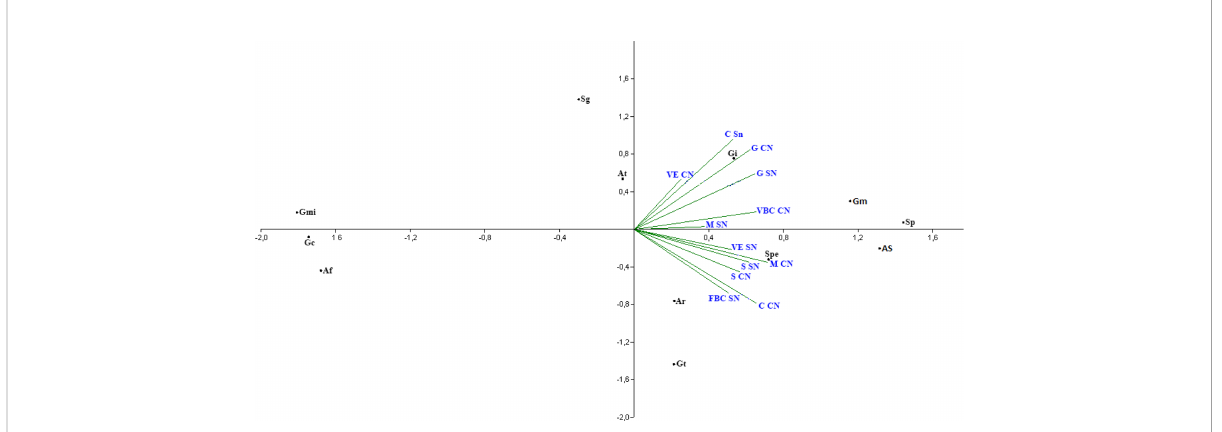
FIGURE 1 Analysis of principal components of the frequency of arbuscular mycorrhizal fungi species found in the rhizosphere of Crotalaria (C), bean — bravo-do-ceara ́ (FBC), sorghum (S), guandu ́ (G), millet (M) and spontaneous vegetation (VE) with and without nitrogen addition. (Af, A. foveata ; At, A. tuberculata ; Ar , Ar. leptoticha ; Gc, G. clarum ; Gmi, G. microaggregatum ; Gt , G. tortuosum ; Gi , Gigaspora sp.; Sg, S. gregaria ; Sp, S. pellucida ; Spe, S. persica ; Gm , G. macrocarpum ; As , A. scrobiculata ).